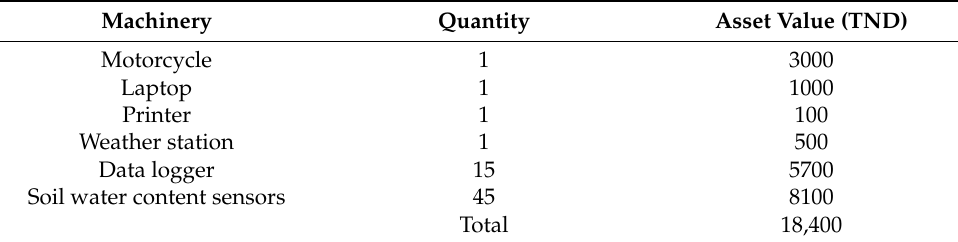
Table 6. Investment costs of the IAS.